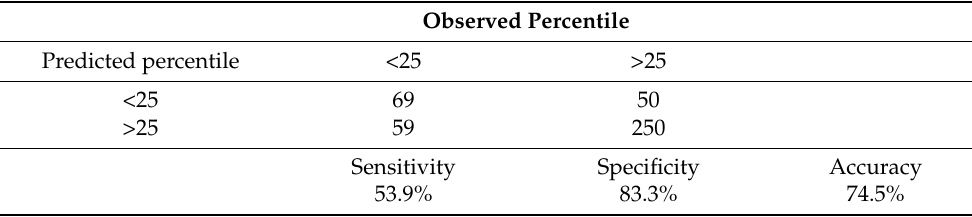
Table 5. Specificity and sensitivity of the